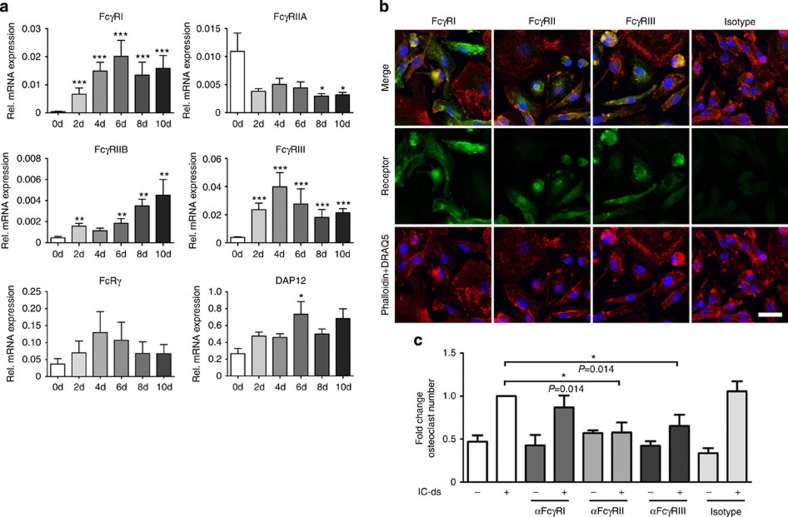
FcγRII and III mediate the signal of non-sialylated immune complexes on preosteoclasts.(a) Quantitative RT-PCR for relative mRNA levels of FcγR and adaptor proteins normalized on β2-microglobulin during osteoclastogenesis. Day 0 represents the stage of monocytes, day 6–8 the stage of late preosteoclasts and day 10 the stage of mature osteoclasts. Bars show mean±s.e.m. of three independent experiments. (b) Fluorescence microscopy images of FcγR expression on human preosteoclasts. FcγR are depicted in green, phalloidin staining for actin is depicted in red and DRAQ5 staining for the nuclei is depicted in blue. Scale bar, 25 μm (representative images of three independent experiments). (c) Fold change of osteoclast number after stimulation of preosteoclasts with 100 μg ml−1 of desialylated immune complexes (IC-ds) in the presence of 10 μg ml−1 of blocking antibodies against indicated FcγR. TRAP-positive cells with ≥3 nuclei were considered as osteoclasts. Bars show mean±s.e.m. of four independent experiments. Statistical analysis was performed with Mann–Whitney U-test. *P<0.5, **P<0.01, ***P<0.001.